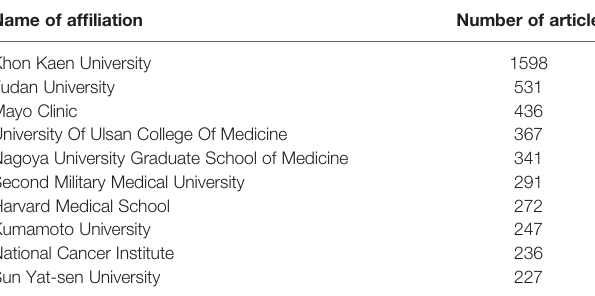
TABLE 1 | Top 10 af fi liations with highest scienti fi c production.